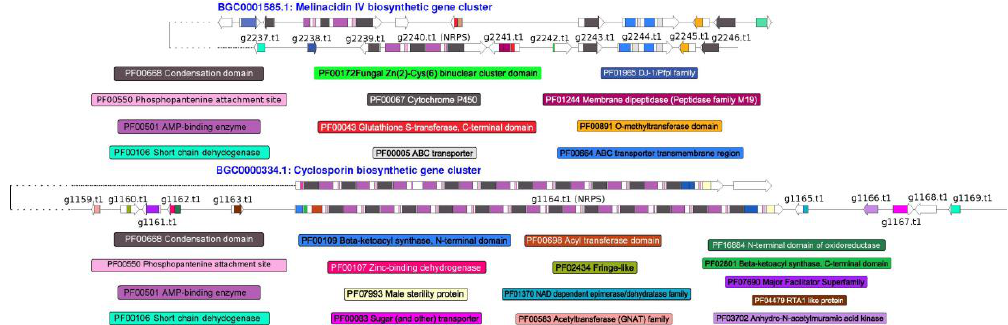
Figure 4. Non-ribosomal peptide synthases ( NRPS ) genes in T. lixii MUT3171: Graphical representation of two NRPS putative gene clusters found in T. lixii MUT3171 showing similarities with melinacidin IV and cyclosporin biosynthetic gene clusters, as provided by the MIBiG repository. For each gene cluster, the genes and their functional domains are reported. Only domains found in T. lixii MUT3171 genes are reported.